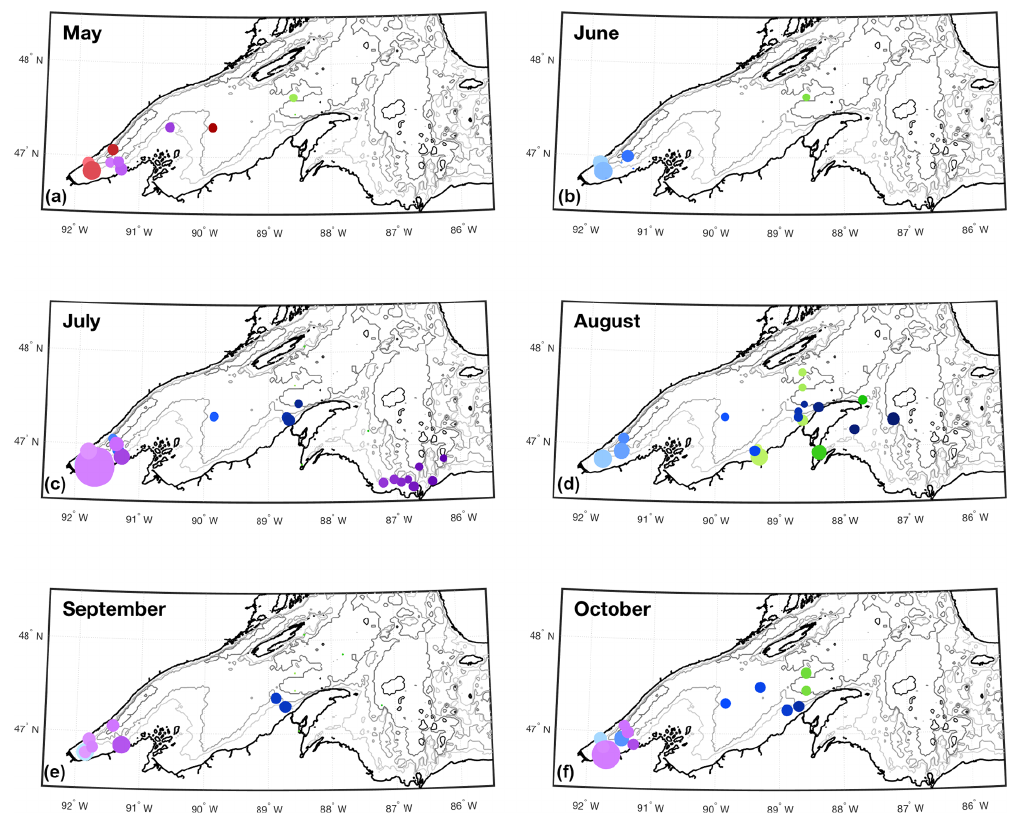
Figure 9. K d (490) (m − 1 ) for the Lake Superior dataset grouped by month. The stations are colored by year and shaded by longitude as in Fig.